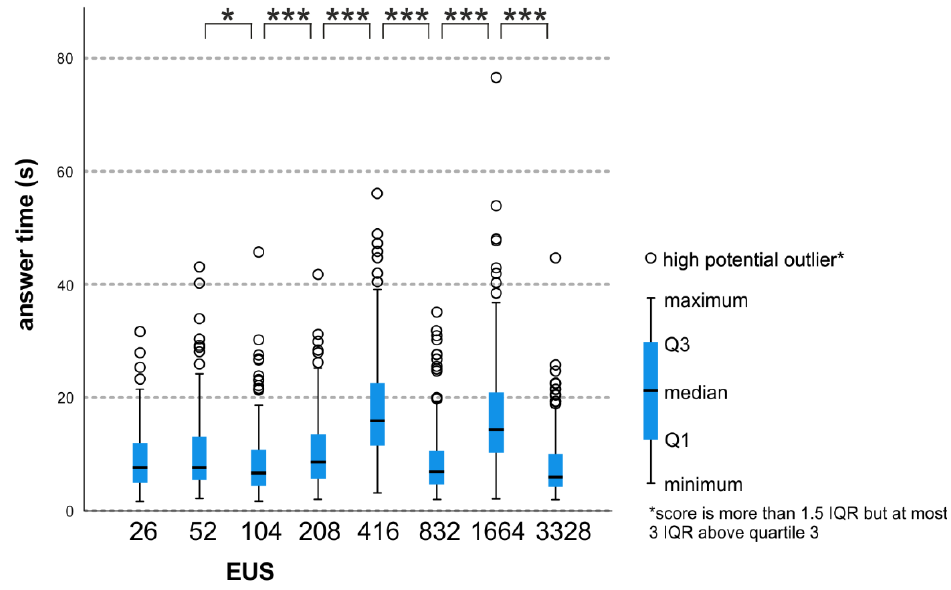
Figure 12. Participants’ answer times pairwise comparison concerning T4: Degree of similarity of the particular enumeration unit sizes, * p < 0.05, *** p ≤ 0.001.